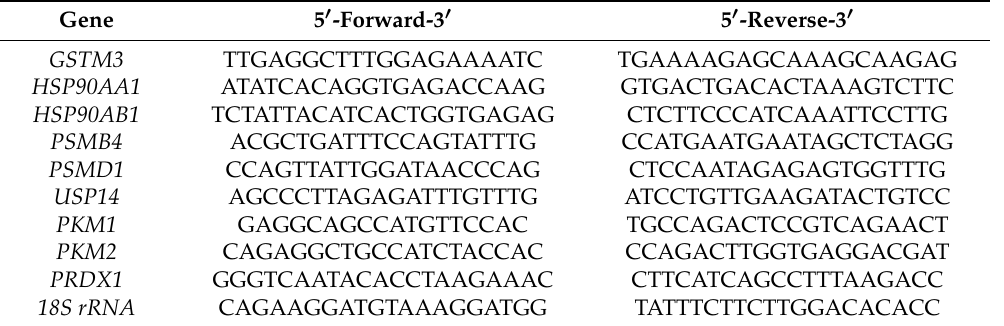
Table 5. List of primers for real-time